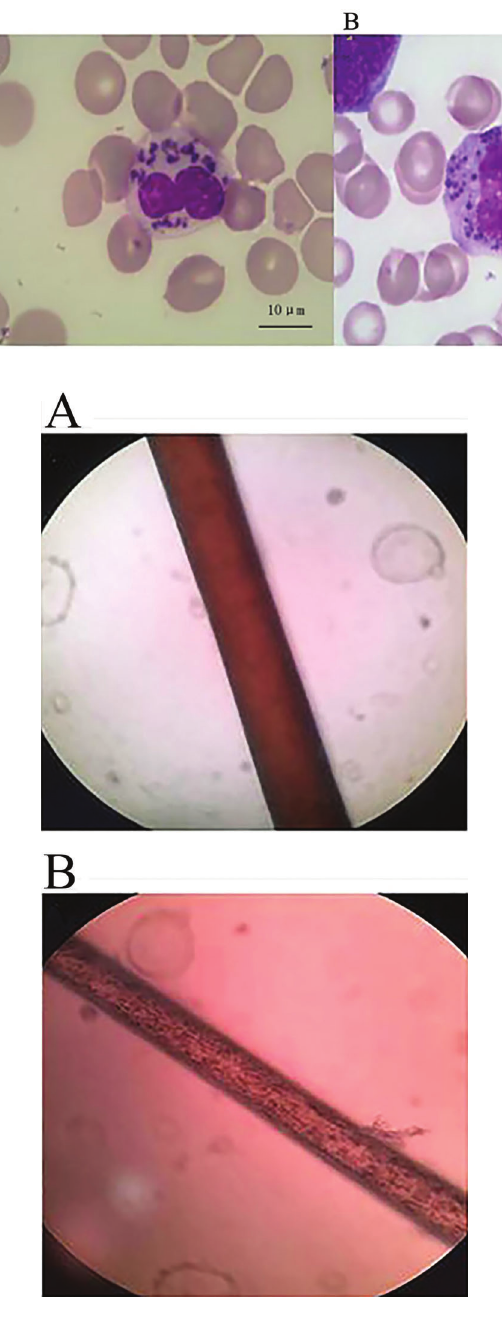
Figure 4. Comparison of normal hair ( A ) and Chediak-Higashi syndrome patient ’ s hair ( B ). Light microscopic images of the boy ’ s hair show abnormal clumping of melanin. Pigment clumps were small and uniformly distributed along the hair